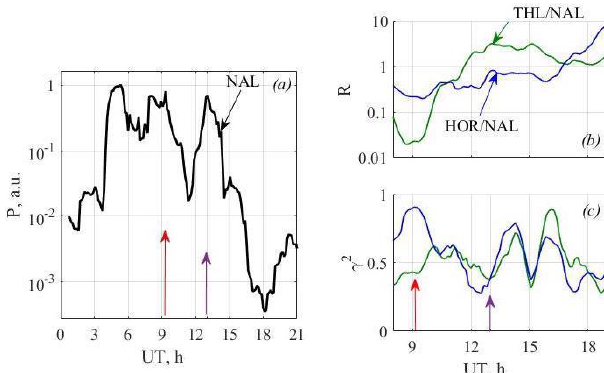
Figure 4. (a) Diurnal variations in the spectral power in the 1.2– 1.9mHz frequency band for the NAL b N component, (b) the PSD spectral ratio ( R ), and (c) spectral coherence ( γ 2 ) for the NAL– THL and NAL–HOR station pairs. Near-noon and afternoon max- ima are marked using